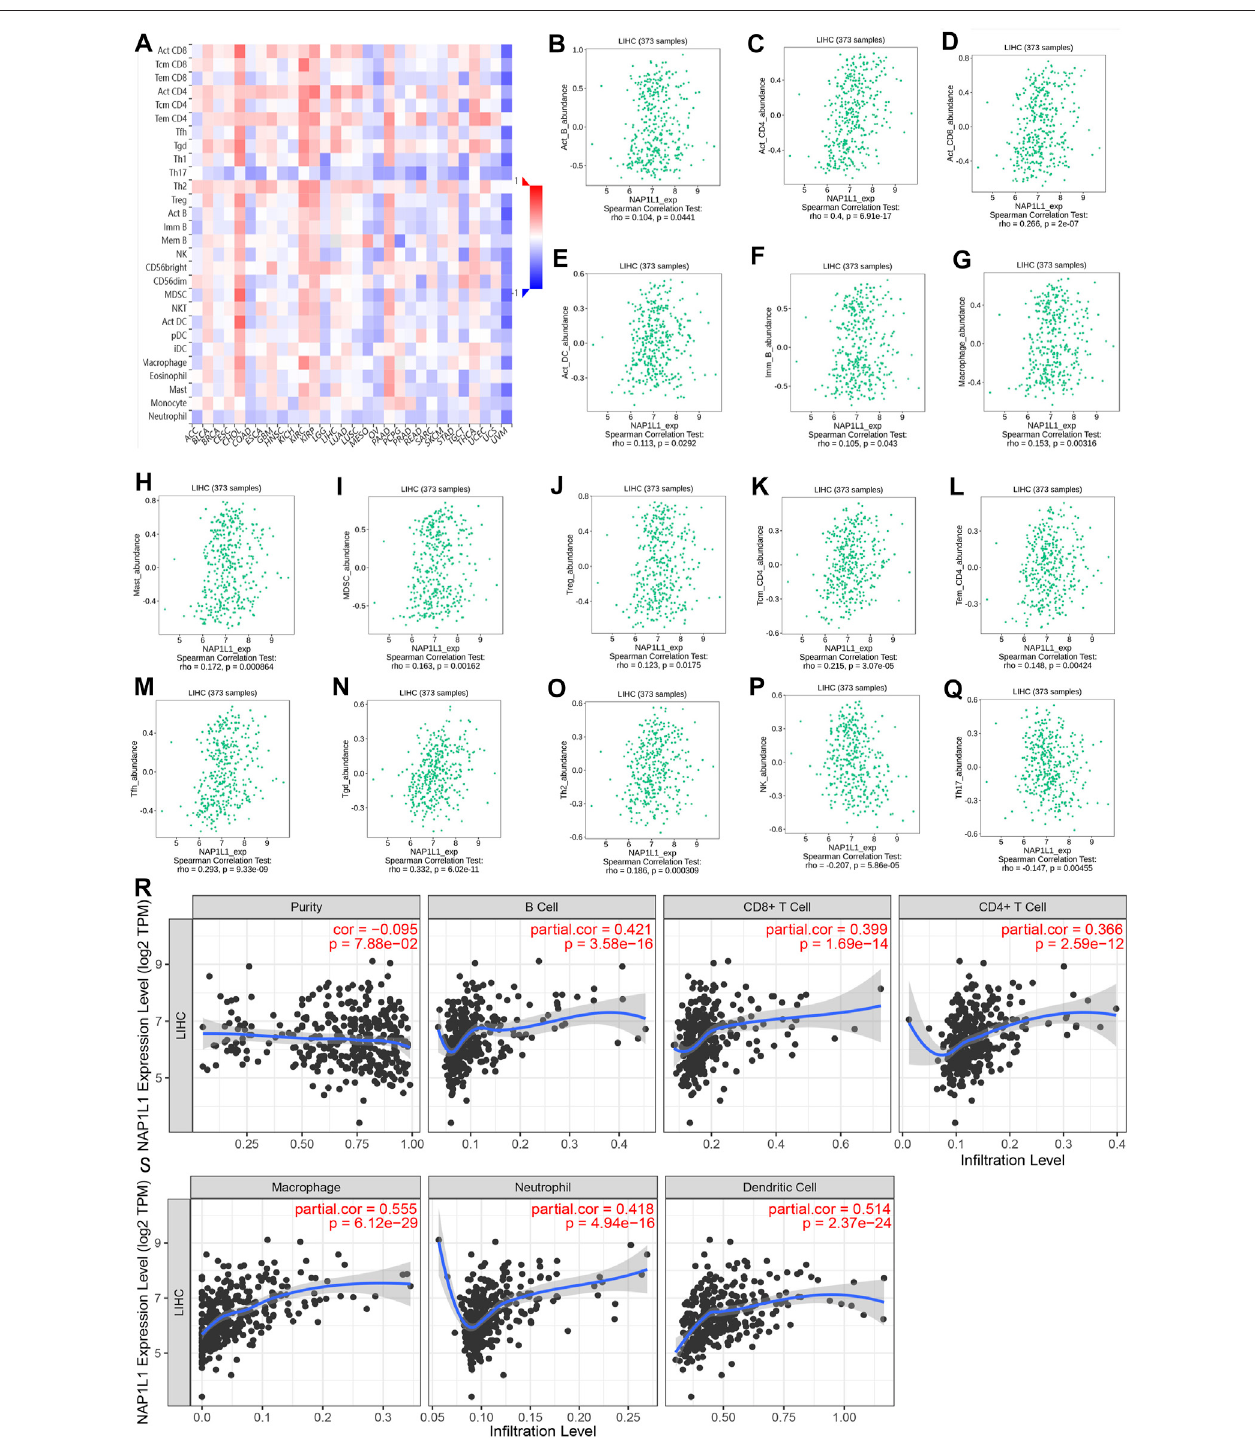
FIGURE 8 | Analysis of immune in fi ltration in TISIDB and TIMER. (A) The panoramic association between the NAP1L1 expression and TILs in human cancer (red represents the positive correlation, and blue represents the negative correlation). (B – O) The NAP1 L1 expression was positively related to the in fi ltrating levels of the immunecell in HCC. (P,Q) The NAP1L1 expression was negatively related tothe in fi ltrating levels of theimmunecell in HCC. (R,S) The NAP1L1 expression iscorrelated with the level of immune in fi ltration.